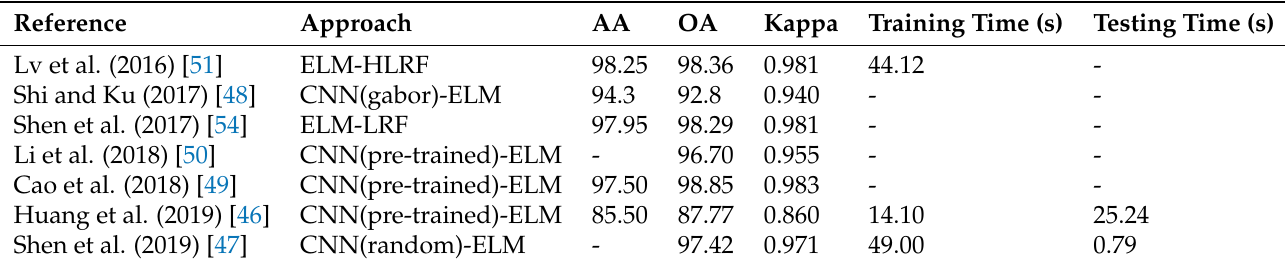
Table 14. Results obtained by CELM architectures for remote sensing classification in the Pavia dataset.